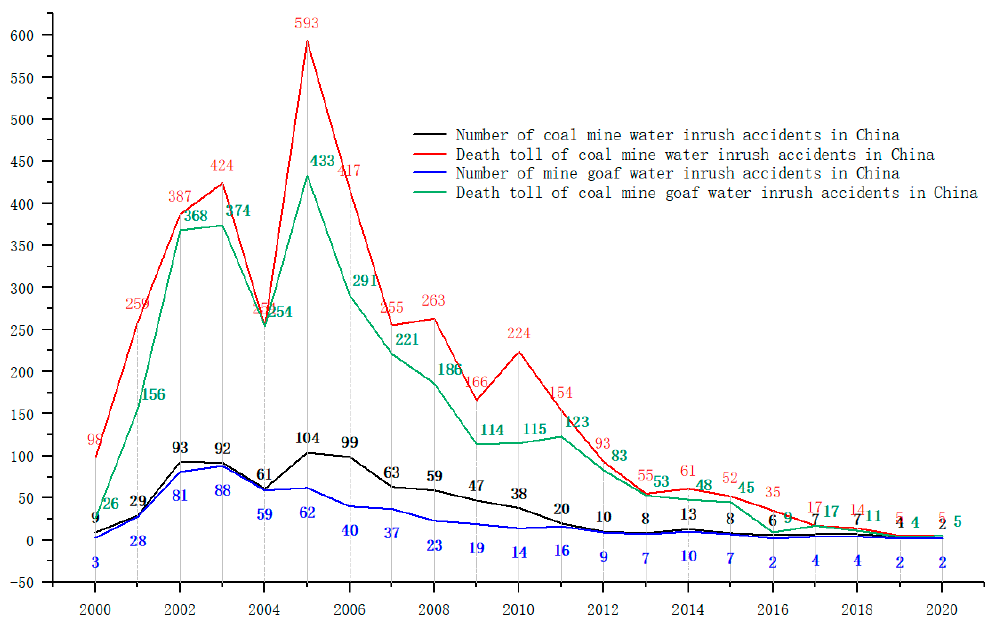
Figure 1. Details of some properties of water inrush accidents from 2000 to 2020 in China.